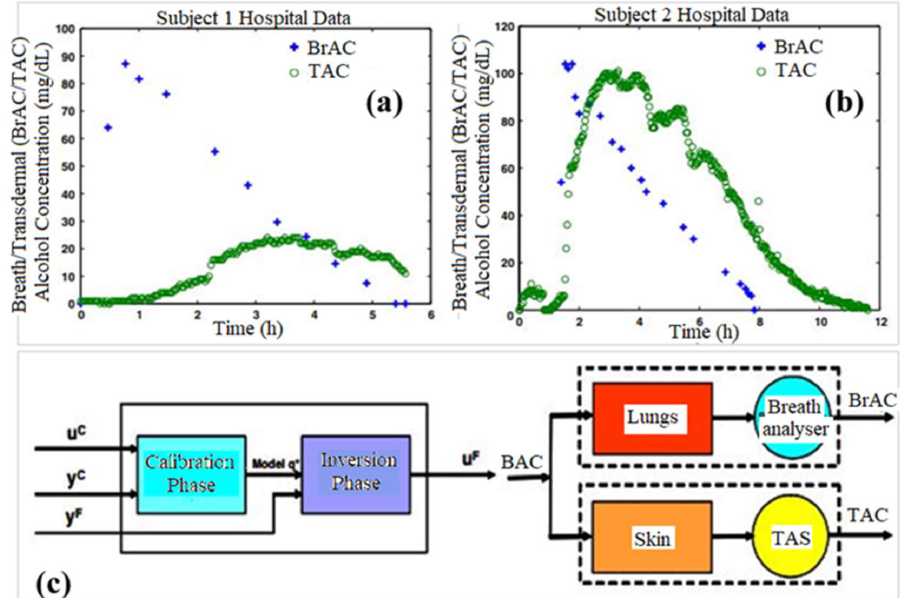
Figure 16. Breath and transdermal data for ( a ) Subject 1 and ( b ) Subject 2. ( c ) Two phase design of the data analysis system (left) and the blood/lung/breath analyzer and blood/skin/TAS systems (right) [44].